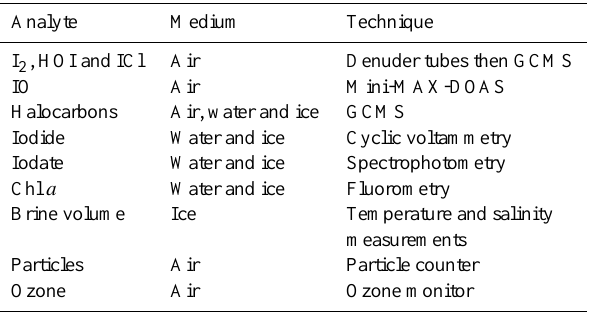
Table 1. Measurements made during cruise ES033. See Sect. 2.2 for details of apparatus.